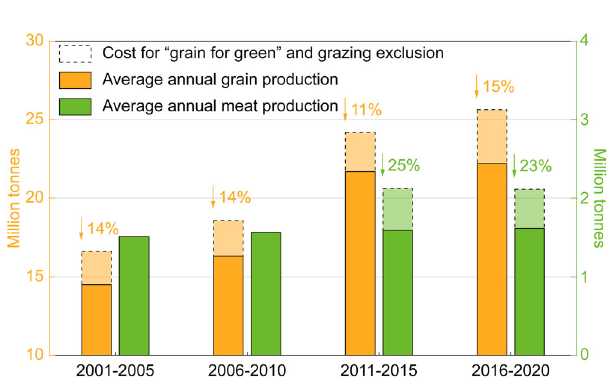
Fig. 3 | Impacts of deserti fi cation-combating practices on grain and meat production. Grain and meat production losses (shown by the dotted box in the fi gure) caused by restrictions on available lands put in place by the “ grain-for- green ” andgrazingexclusionpracticesinthedeserti fi cation-proneregion.Because these two practices have been extensively launched since 2001 and 2011, respec- tively (Supplementary Note 2), the grain and meat production losses were esti- mated for the simultaneous periods. More details are provided in the Methods